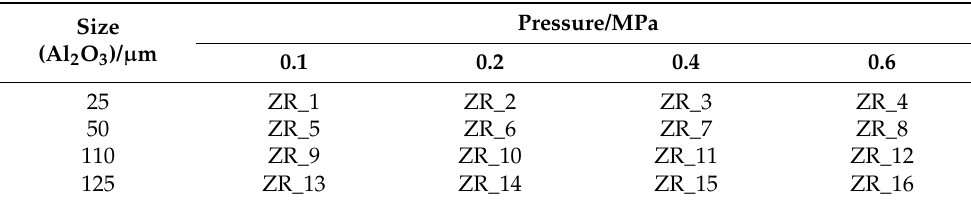
Table 1. Names of the samples obtained by sandblasting the ZR control sample disk with different Al 2 O 3 particles and various amounts of